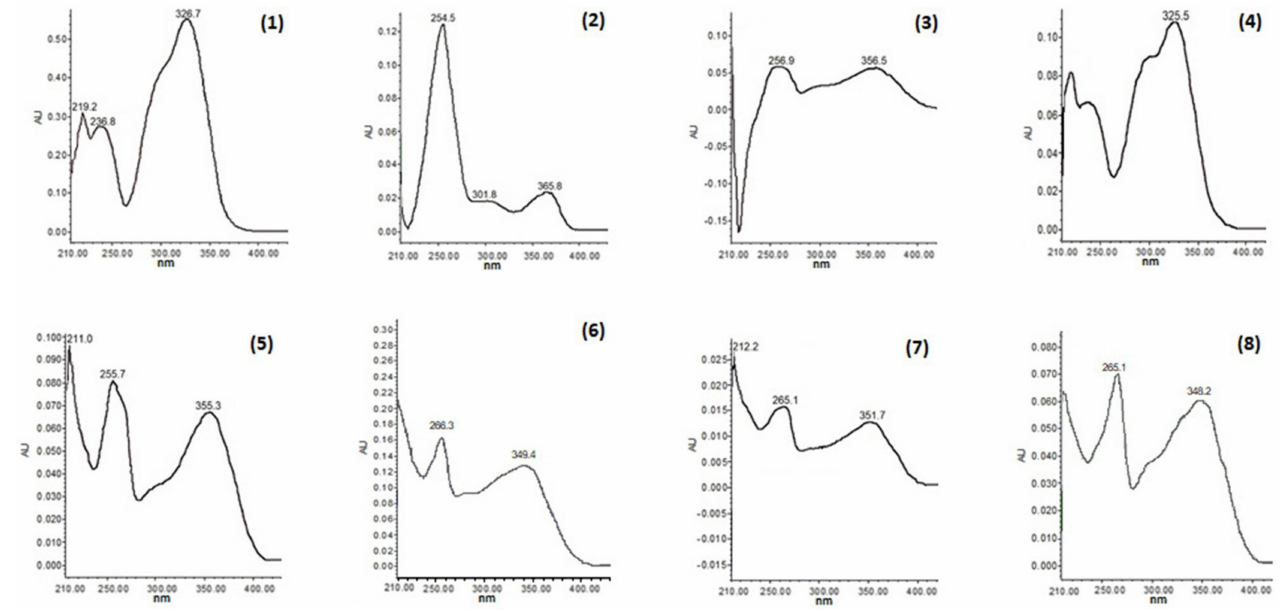
Figure 1. HPLC chromatogram of the phenolic compounds ( 1 – 16 ) in the three species of white oak ( Q. rugosa , Q. obtusata, and Q. glabrescens ). Wavelength of the chromatograms made at 320 nm. N.I. = not identified.